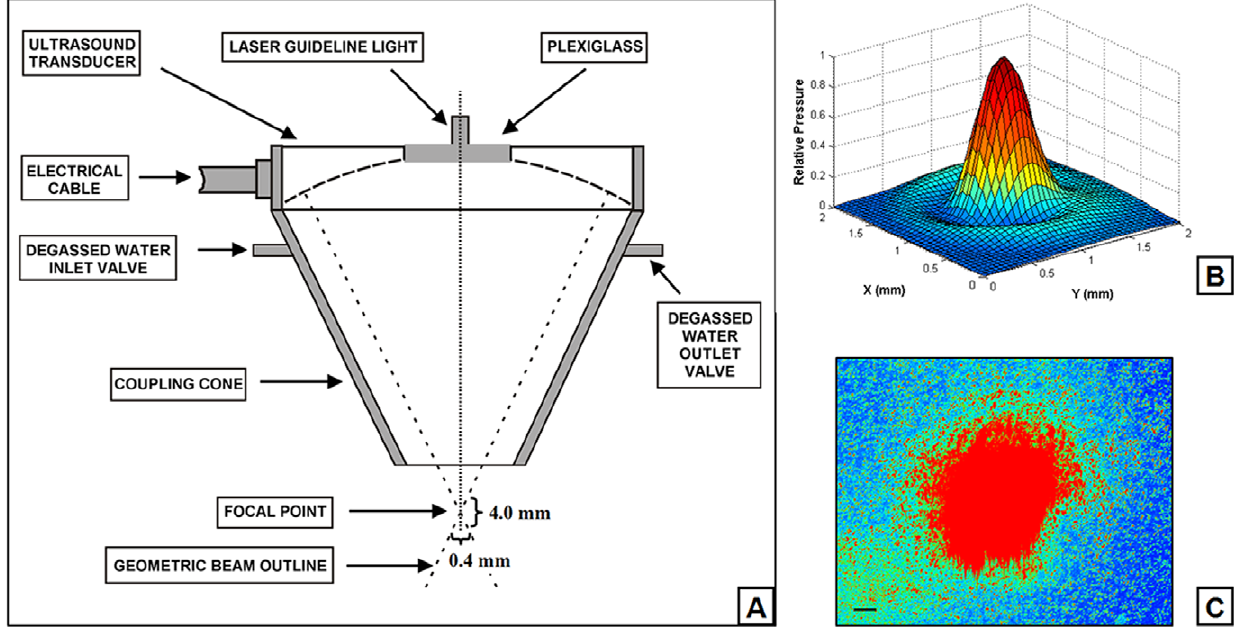
Figure 2. Schematic diagram of the transducer assembly. A : Spherical transducer with coupling cone and a centrally attached laser guideline light. The ellipsoidal acoustic focal zone covers approximately 4 mm axially and 0.4 mm transversely at the half-pressure points. B : Normalized pressure distribution through the culture dish for the single element on the radial plane at the distance of 62.75 mm of the transducer’s surface. C : The focal point of focused ultrasound guided by red laser light in the middle field of view of the microscope objective. Scale bar, 50 m m.